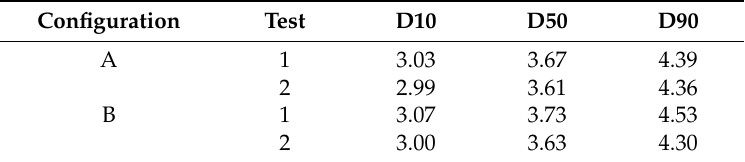
Table 6. Particle size distribution for two tests at each spreader configuration (mass based). The 10th, 50th and 90th percentile are given (all in mm).